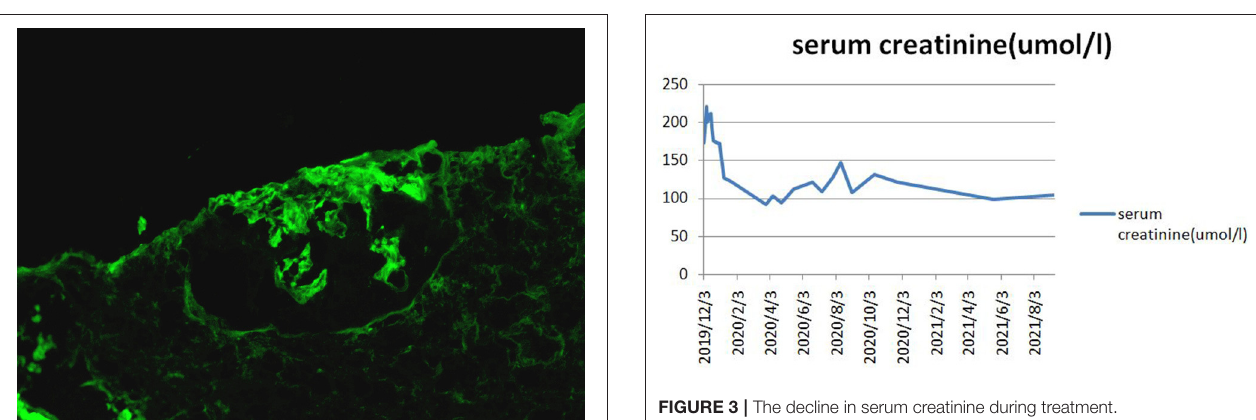
FIGURE 3 | The decline in serum creatinine during